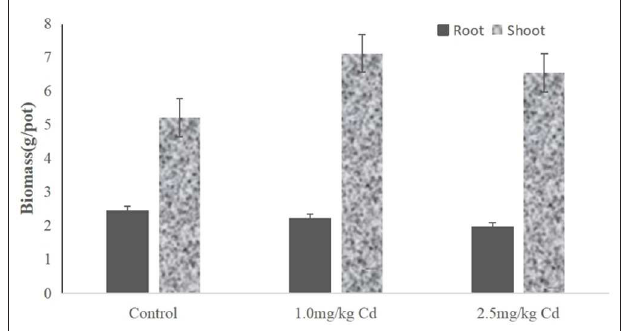
FIGURE 1 | The height of snapdragons in the pot-culture experiment.